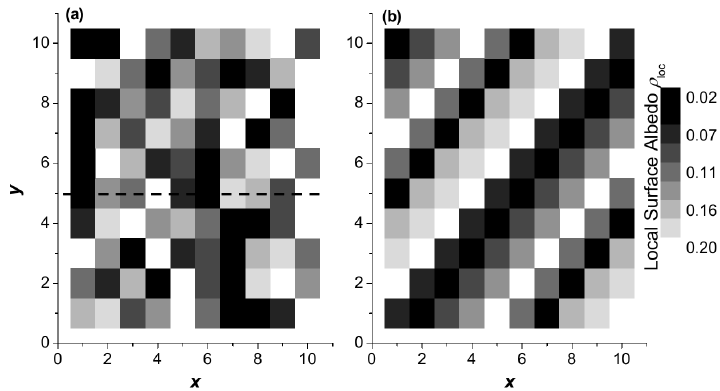
Fig. 5. Albedo maps with different distributions: (a) randomly and (b) systematically with variable grid size between 0.1 and 2km. The dashed line marks the position of a cross-section through the model domain.